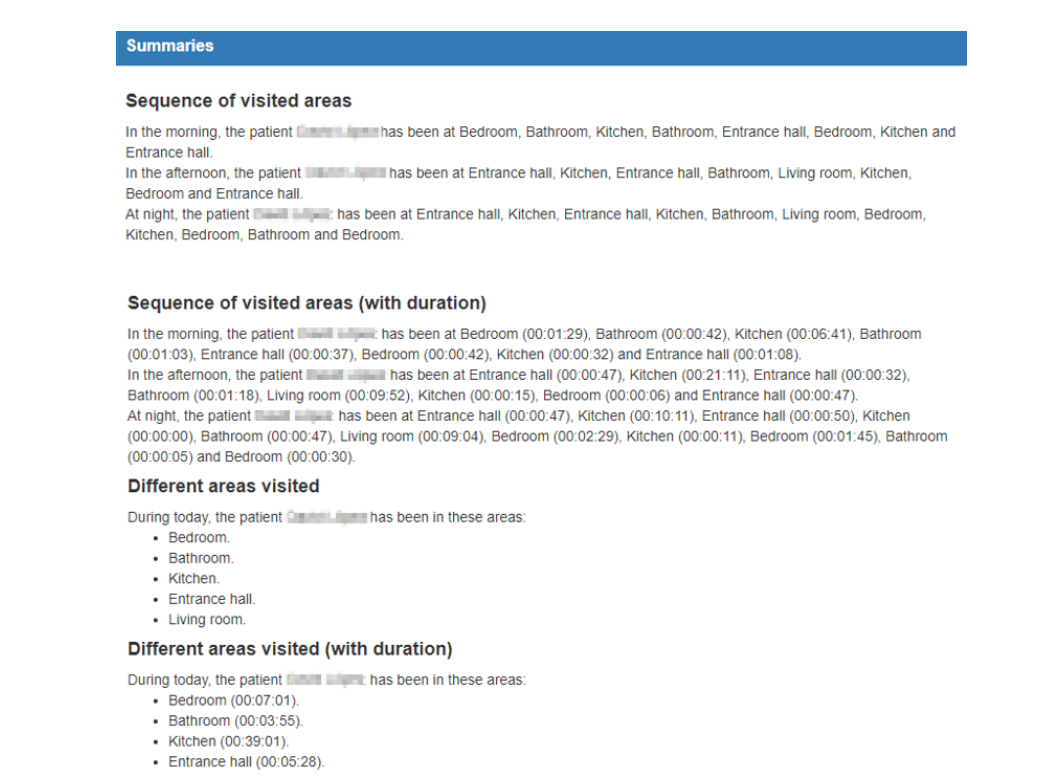
Figure 12. Summaries of the areas visited during a particular day in natural language.